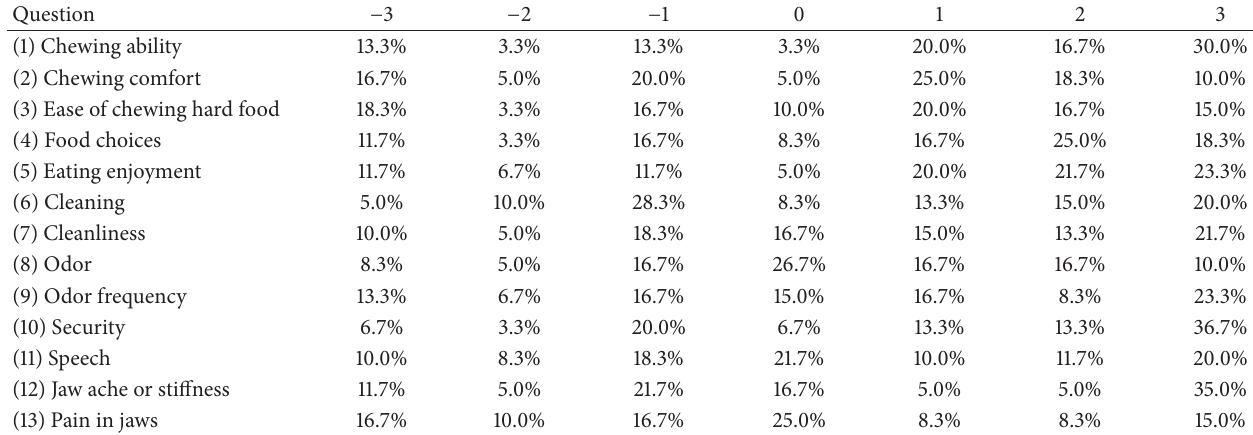
Table 2: Patients’ ( 𝑛 = 60 ) satisfaction with their complete dentures after restoring OVD and relining based on their answers to Questionnaire II.